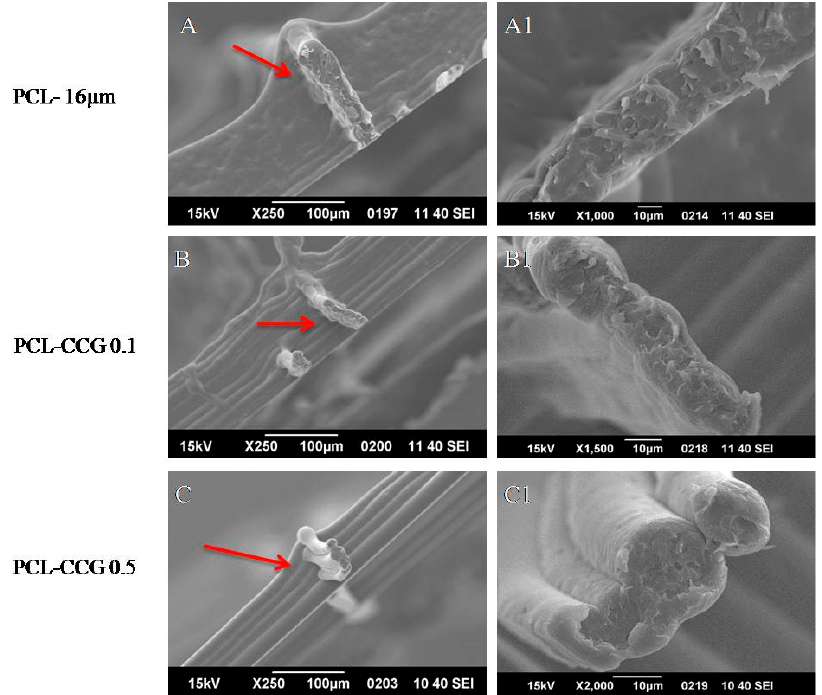
Figure 6. SEM images of MEW PCL and PCL composites at low magnifications ( A – C ) and high magnifications ( A1 – C1 ) with arrows indicating layer separation. magnifications ( A1 – C1 ) with arrows indicating layer